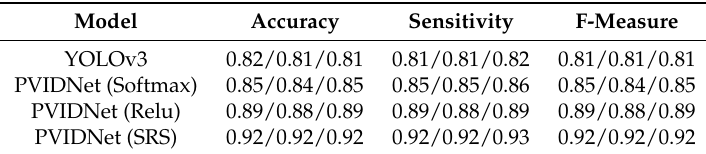
Table 9. Results of the DL algorithms to classify the images of regular cars (right/left/front) in the training phase.